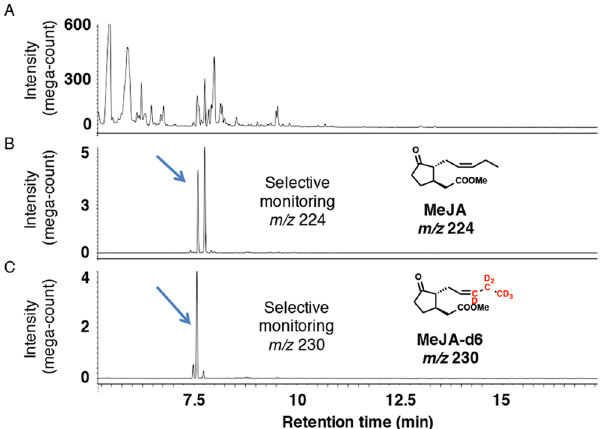
Figure 6. Representative GC-MS chromatograms for measuring MeJA in feeding experiment using OPC 8:0- d6. ( A ) Representative GC-MS chromatogram monitoring total ion. ( B ) Representative GC-MS chromatogram for measuring fungal derived MeJA using selected ion monitoring at m / z 224. ( C ) Representative GC-MS chromatogram for measuring fungal derived MeJA-d6 using selected ion monitoring at m / z 230. Representative MS chart of the peak indicated by arrow is given in Supplementary Figure S6.